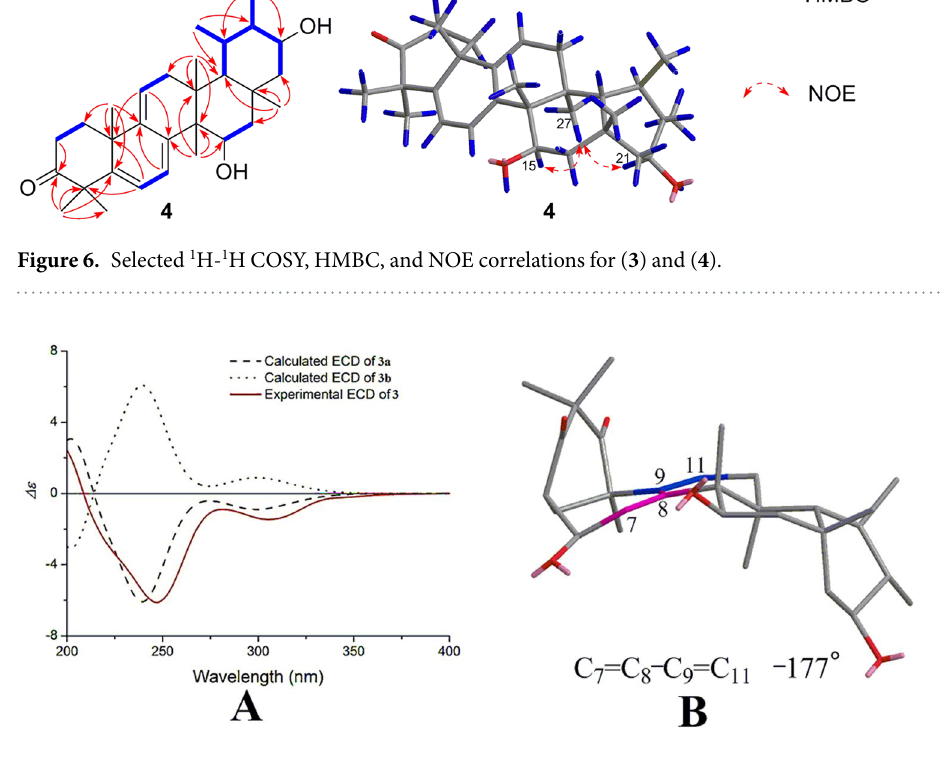
Figure 7. ( A ) Experimental ECD spectrum of 3 , using TDDFT at the B3LYP/6-31 G(d) level in MeOH calculated ECD spectra of 3a and 3b . ( B ) Application for the helicity rule of 3